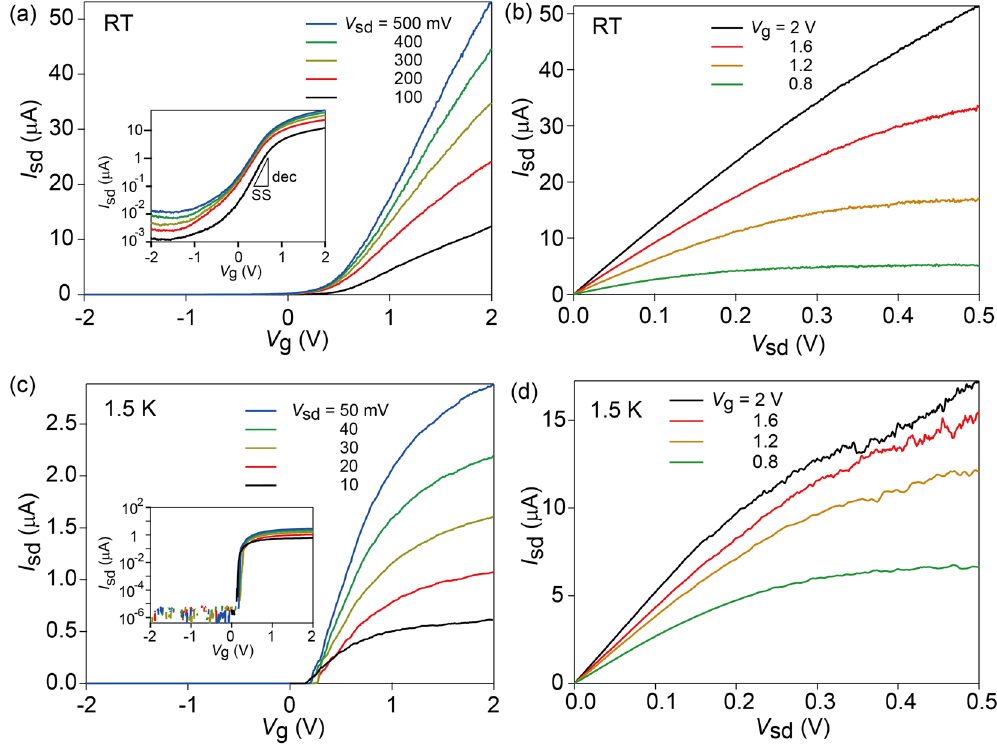
Figure 2. ( a , c ) Transfer characteristics obtained for various V sd values at ( a ) room temperature and ( c ) 1.5 K. The insets show the log-scale of the plots, and the subthreshold slope. ( b , d ) Output characteristics obtained for various V g values at ( b ) room temperature and ( d ) 1.5